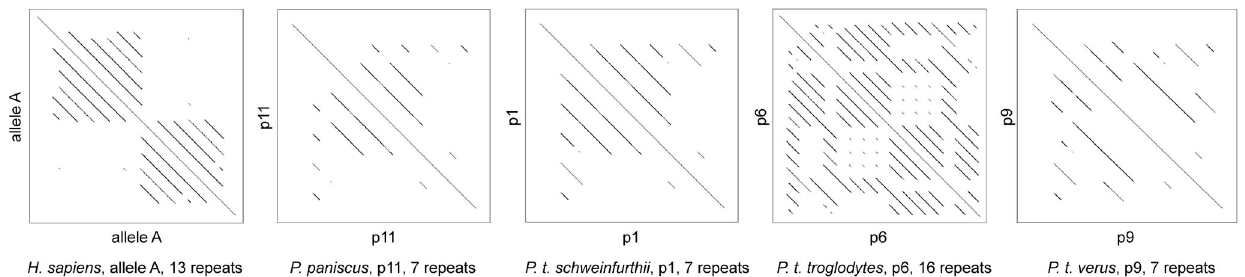
Figure 3. Self-comparison of predominant PRDM9 alleles. These diagrams depict the results of an analysis comparing PRDM9 DNA sequences to themselves with a window size of 83 and a mismatch limit of five. The main diagonal represents the alignment of a sequence to itself. The off- diagonal lines represent similar patterns within the sequences. The human allele shows a clear two-block structure, in which the repeats of the first half of the sequence are more similar to one another than to those in the second half of the sequence and vice versa. This structure is not seen in any of the Pan alleles.